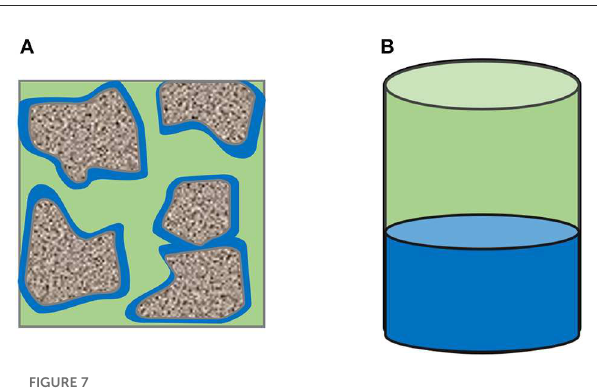
FIGURE7 Specific contact area of gas and water in porous media and reactors; green = gas, blue = reactive water. (A) Phase distribution inside the porous medium. (B) Phase distribution inside the